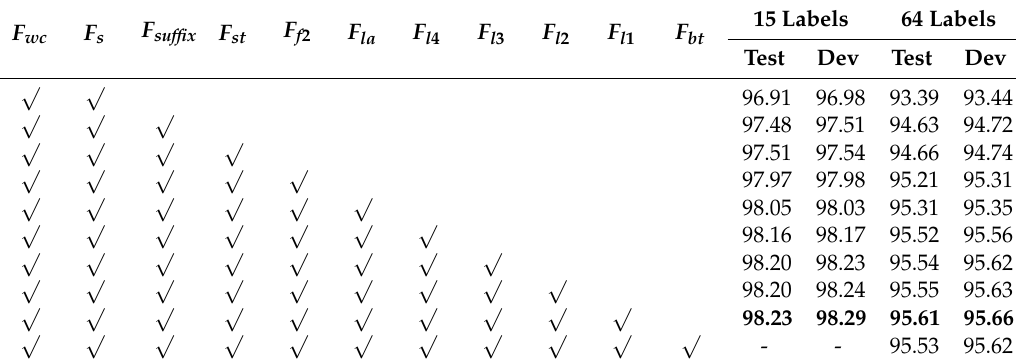
Table 5. Performance of different engineered features